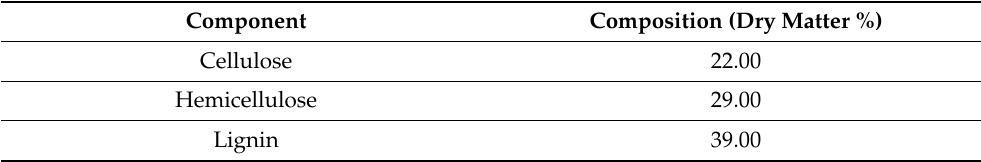
Table 8. Composition of empty fruit bunch